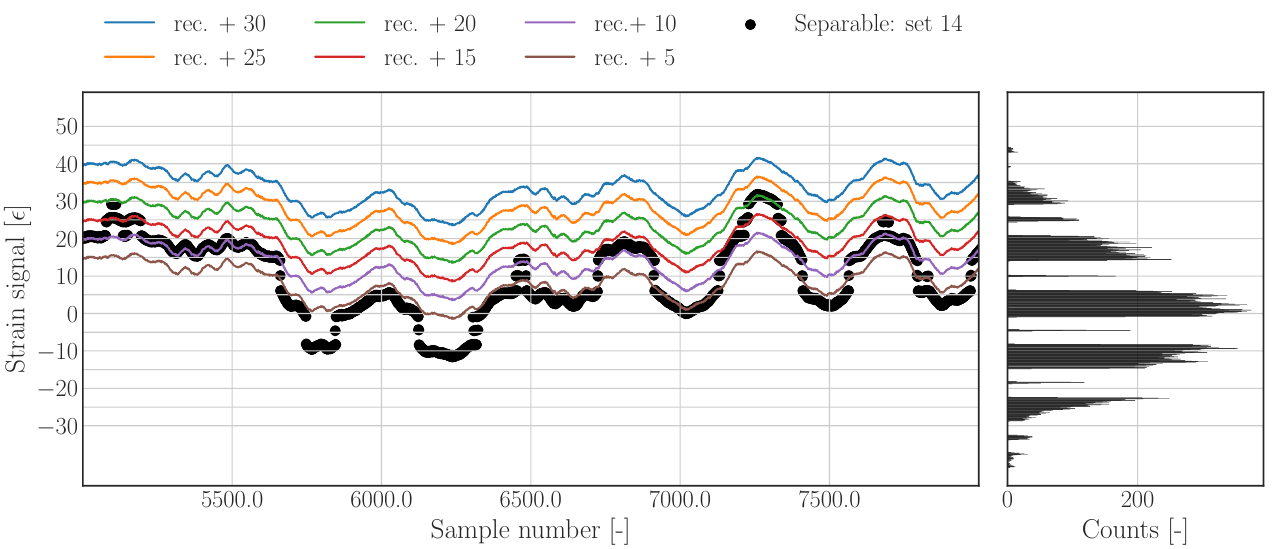
Figure 6. Left : subset of the raw and reconstructed time series with different mean values, illustrating the problem of deriving a mean value from the raw signal. Right : histogram of the full raw signal illustrating the distribution of samples over the signals range as well as the jumps in the